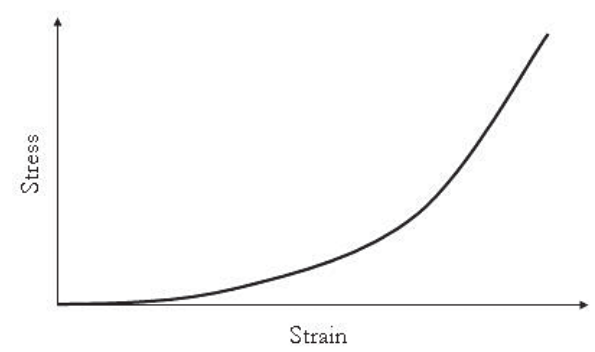
Figure 5 Typical stress–strain curve of the facial soft